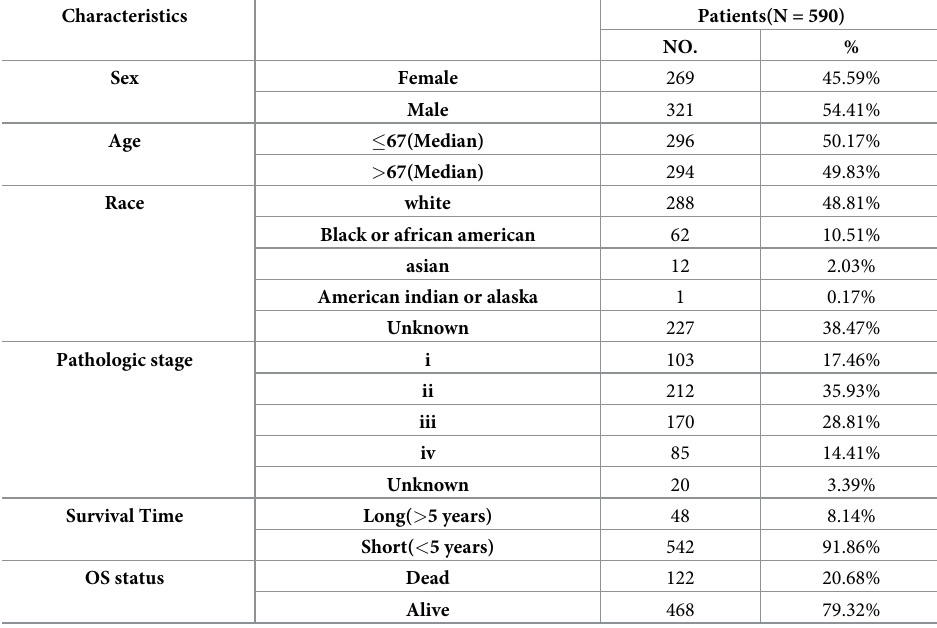
Table 1. Clinicopathological features of colon and rectal cancer patients in TCGA dataset.